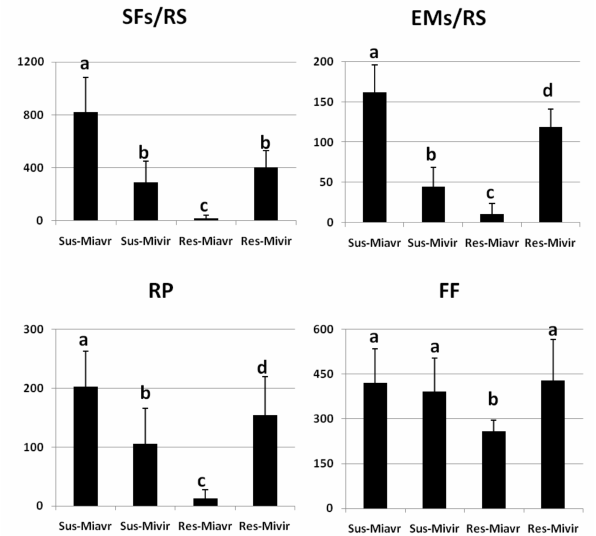
Figure 2. Infection factors of susceptible and resistant tomato plants inoculated with the avirulent Meloidogyne incognita field population Mi-Vfield and the selected virulent isolate SM2V . Infection factors of four interactions are shown: Roma VF / Mi-Vfield (Sus-Miavr); Roma VF / SM2V (Sus-Mivir); Rossol / Mi-Vfield (Res-Miavr); Rossol / SM2V (Res-Mivir). Infection level was characterized by the numbers of Sedentary Forms per Root System (SFs / RS), Egg Masses per Root System (EMs / RS), Reproduction Potential (RP), and Female Fecundity (FF).Values are expressed as means ( n = 9) ± standard deviations. Means were separated by a Duncan’s Test, di ff erent letters indicate significantly di ff erent means (Significance Level: